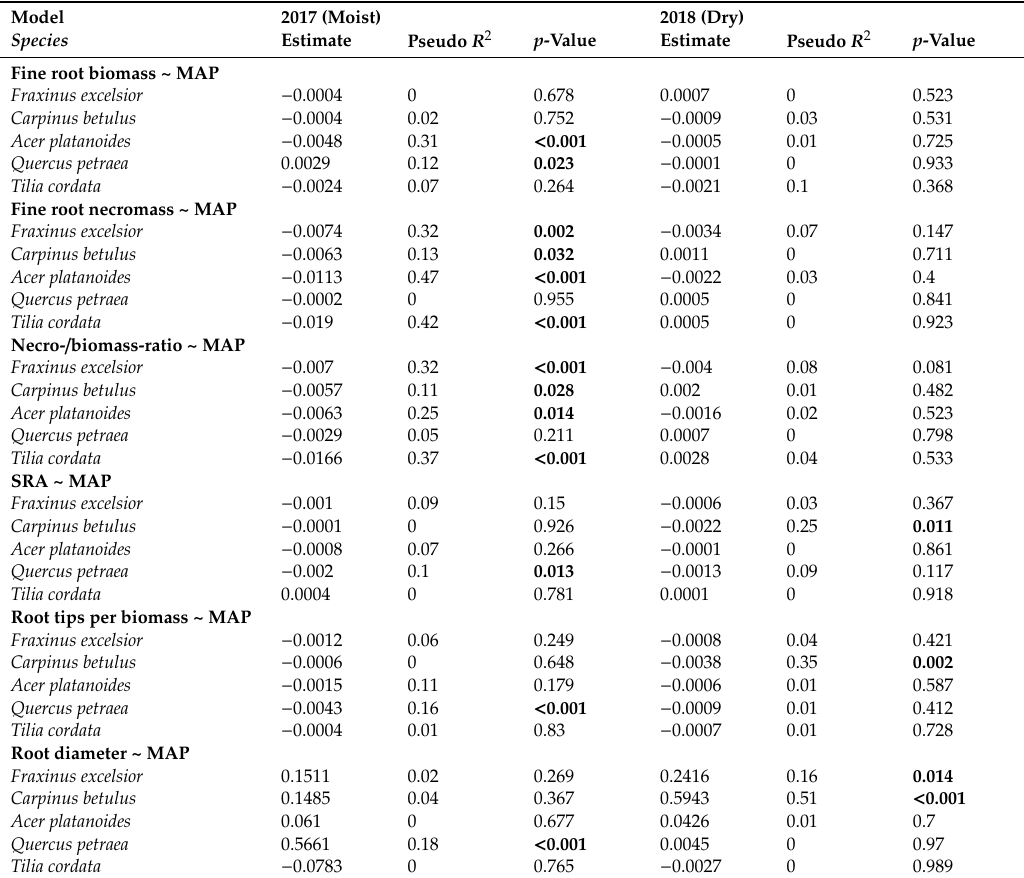
Table 3. Results of linear mixed e ff ects models for fine root traits in dependence of mean annual precipitation (MAP). Given are estimates of the fixed e ff ect (fine root trait ~ species: MAP), marginal pseudo- R 2 for the fixed e ff ect (calculated according to Nakagawa and Schielzeth (2013)), and p -values. p -values below 0.05 are given in bold. All fine root traits were log-transformed in advance except for root